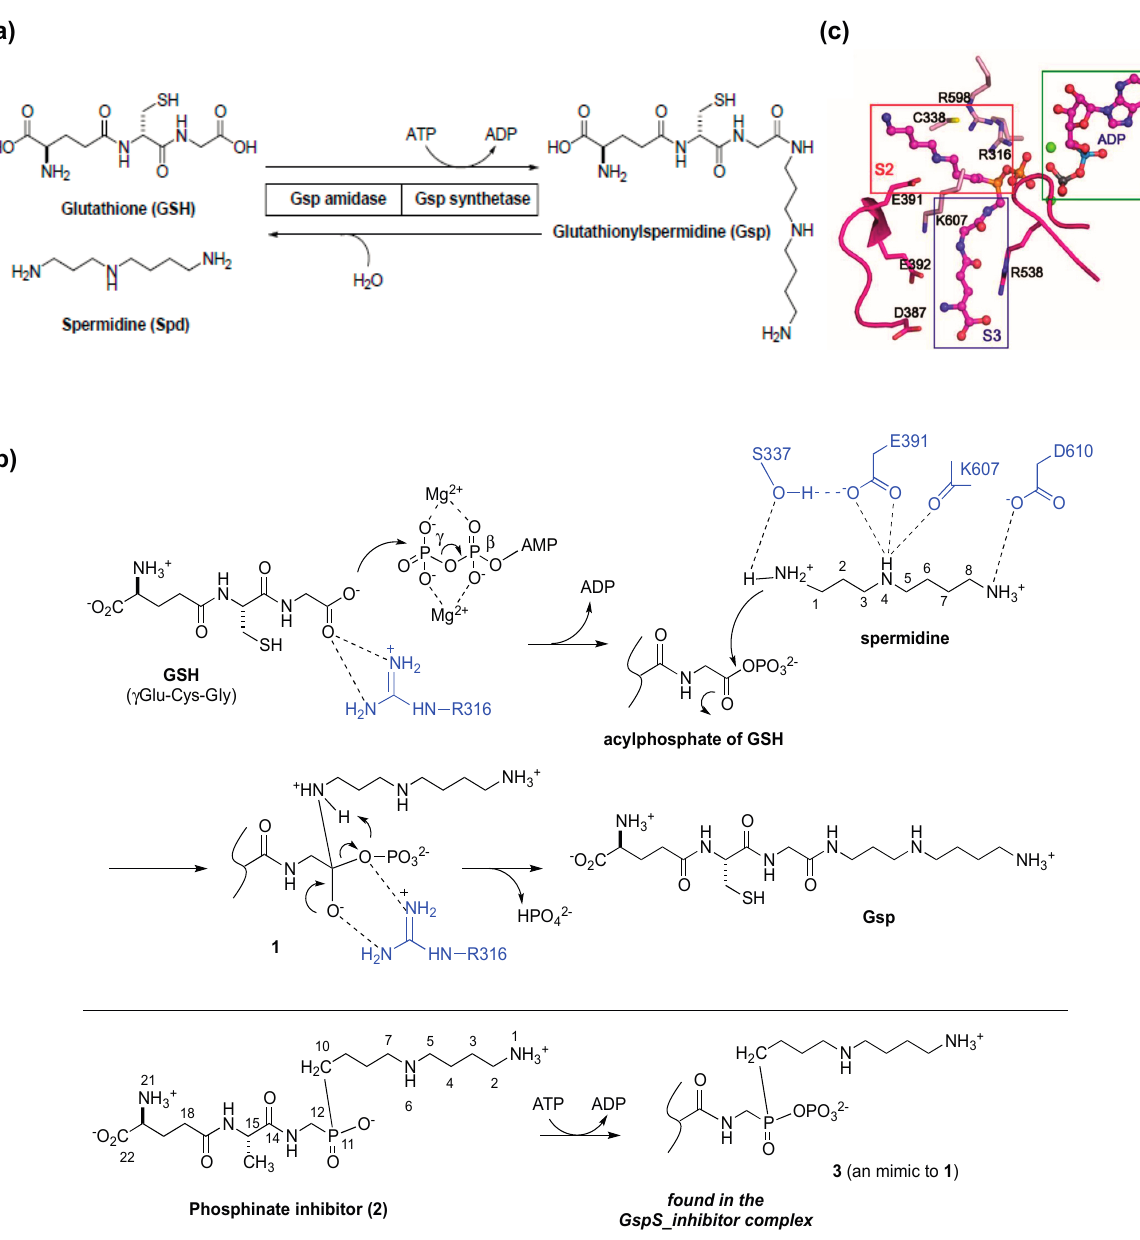
Figure 2. ( a ) The reactions catalyzed by E. coli glutathionylspermidine synthetase/amidase (GspSA). GspSA from E. coli is a bifunctional protein that contains an N-terminal amidase domain and a C-terminal synthetase domain. The two catalyzed reactions are shown at the molecular level; ( b ) Proposed reaction mechanism of GspS. The conjugation reaction of GSH with spermidine proceeds in two steps—the C terminus of GSH is initially phosphorylated by γ -phosphate of ATP to form an acylphosphate, followed by the nucleophilic attack of N1-spermidine to the acylphosphate; ( c ) Structure of inhibitor-bound GspS ( GspS_inhibitor ) at the S2 and S3 substrate-binding pockets near four negatively charged residues Asp387, Asp389, Glu391 and Glu392. Figure 2a was reproduced from [26] © The American Society for Biochemistry and Molecular Biology. Figure 2b,c were reproduced from [30] © European Molecular Biology